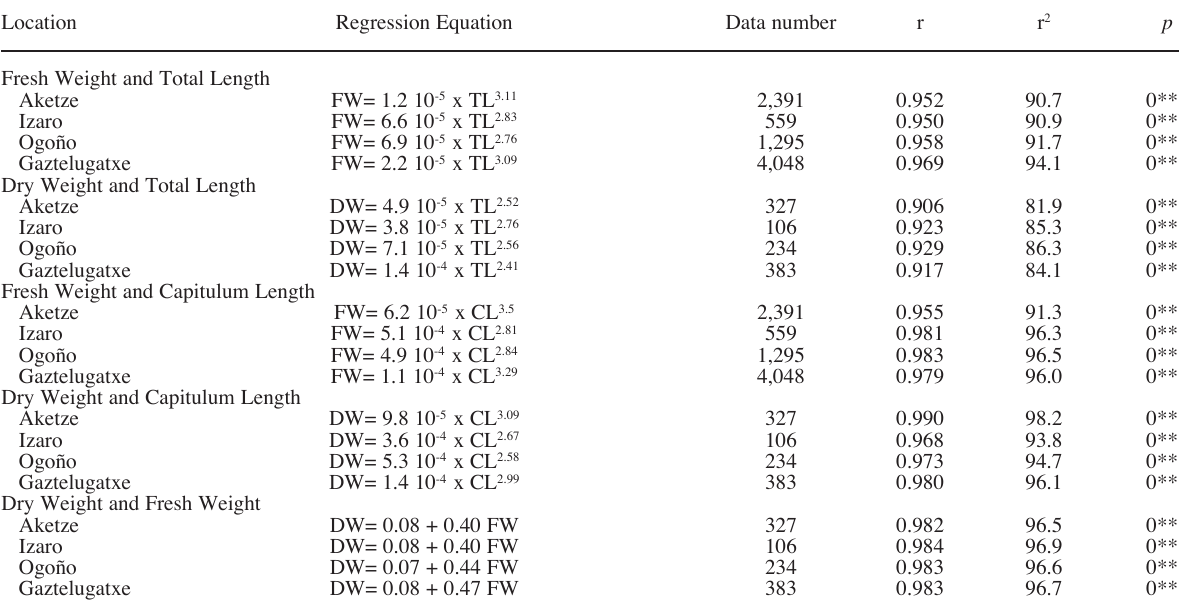
T ABLE 3. – Allometric relationships for each of the locations. Key: FW=fresh weight; DW=dry weight; TL=total length; CL=capitulum length; r=correlation; r 2 = explained variability (%); p -significance; and *** significant correlation, at p <0.001. Location